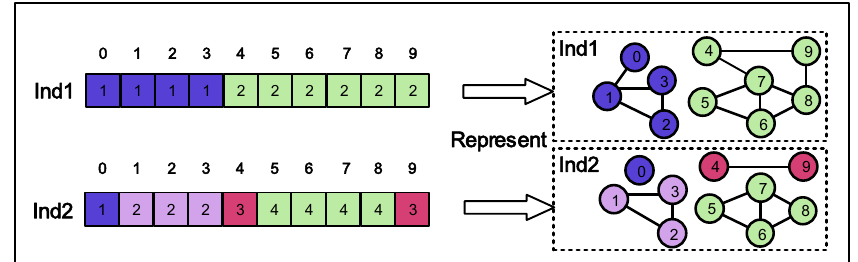
Figure 1. Two examples of solution